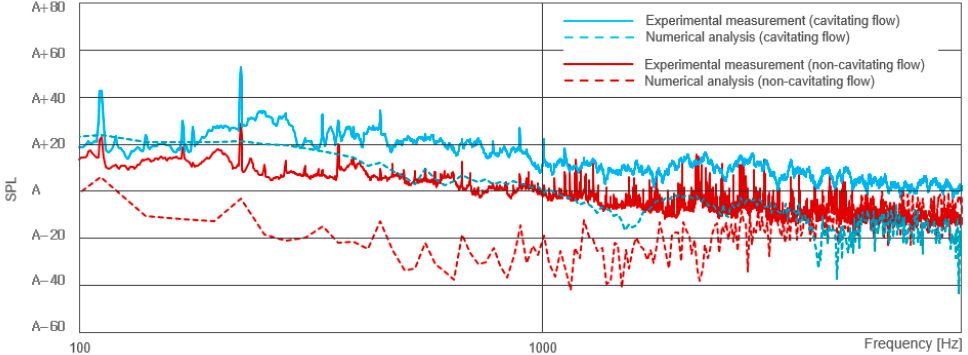
Figure 20. Sound pressure levels of model 1 in non-cavitating and cavitating flows.